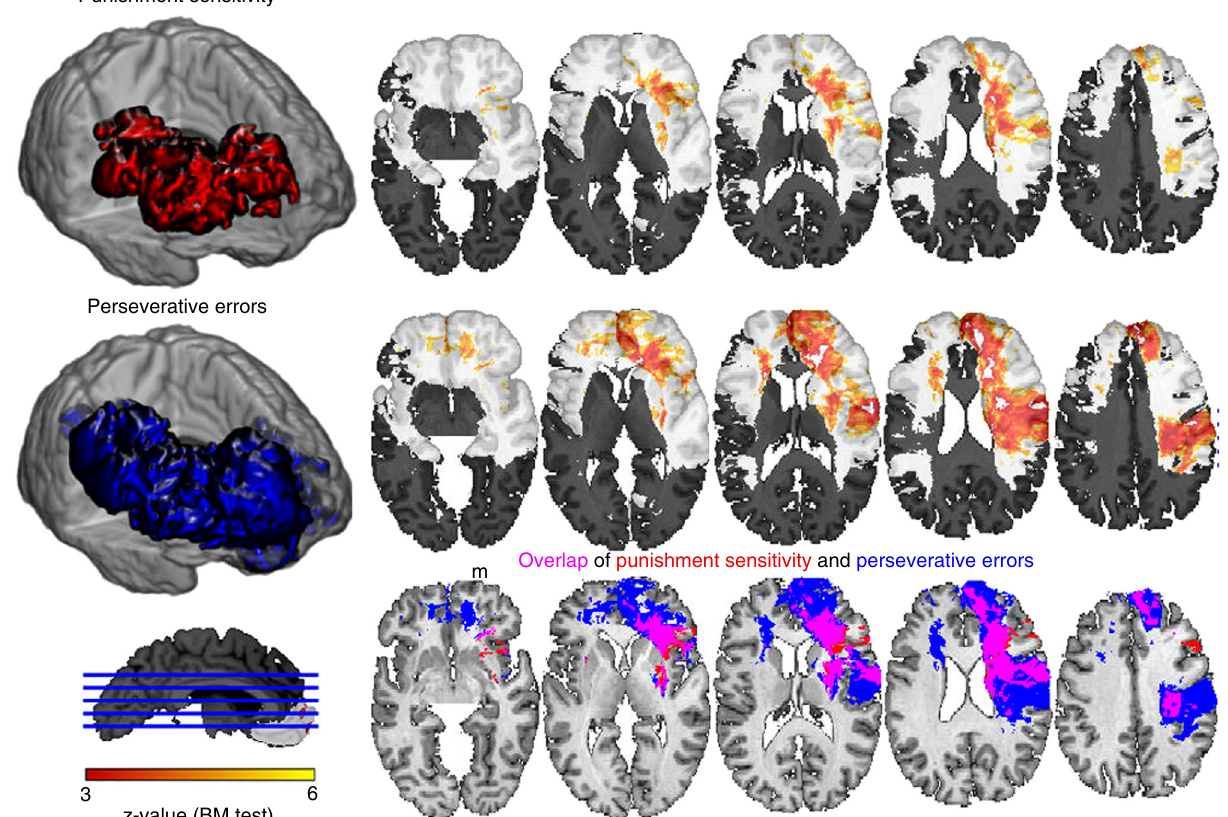
Fig. 4 Univariate lesion mapping of WCST scores and model parameters. Punishment sensitivity (P) and perseverative errors (PSV) showed a signi fi cant lesion effect in right PFC encompassing dlPFC and frontal pole and stretching to posterior frontal and parietal cortex. Individual results for both variables are shown on transverse slices (the right hemisphere is on the right in these slices). Shaded areas indicate regions of insuf fi cient statistical power given our 1% FDR threshold. The three-dimensional (3D) shapes of the lesion effects are shown in the colors used in the overlap slices. The overlap in the bottom panels corresponds to a conjunction analysis. Note that this is not a statistical interaction term; the three colors simply denote overlap or non-overlap, not statistical independence. Scale: z -score obtained from the Brunner – Munzel test implemented in